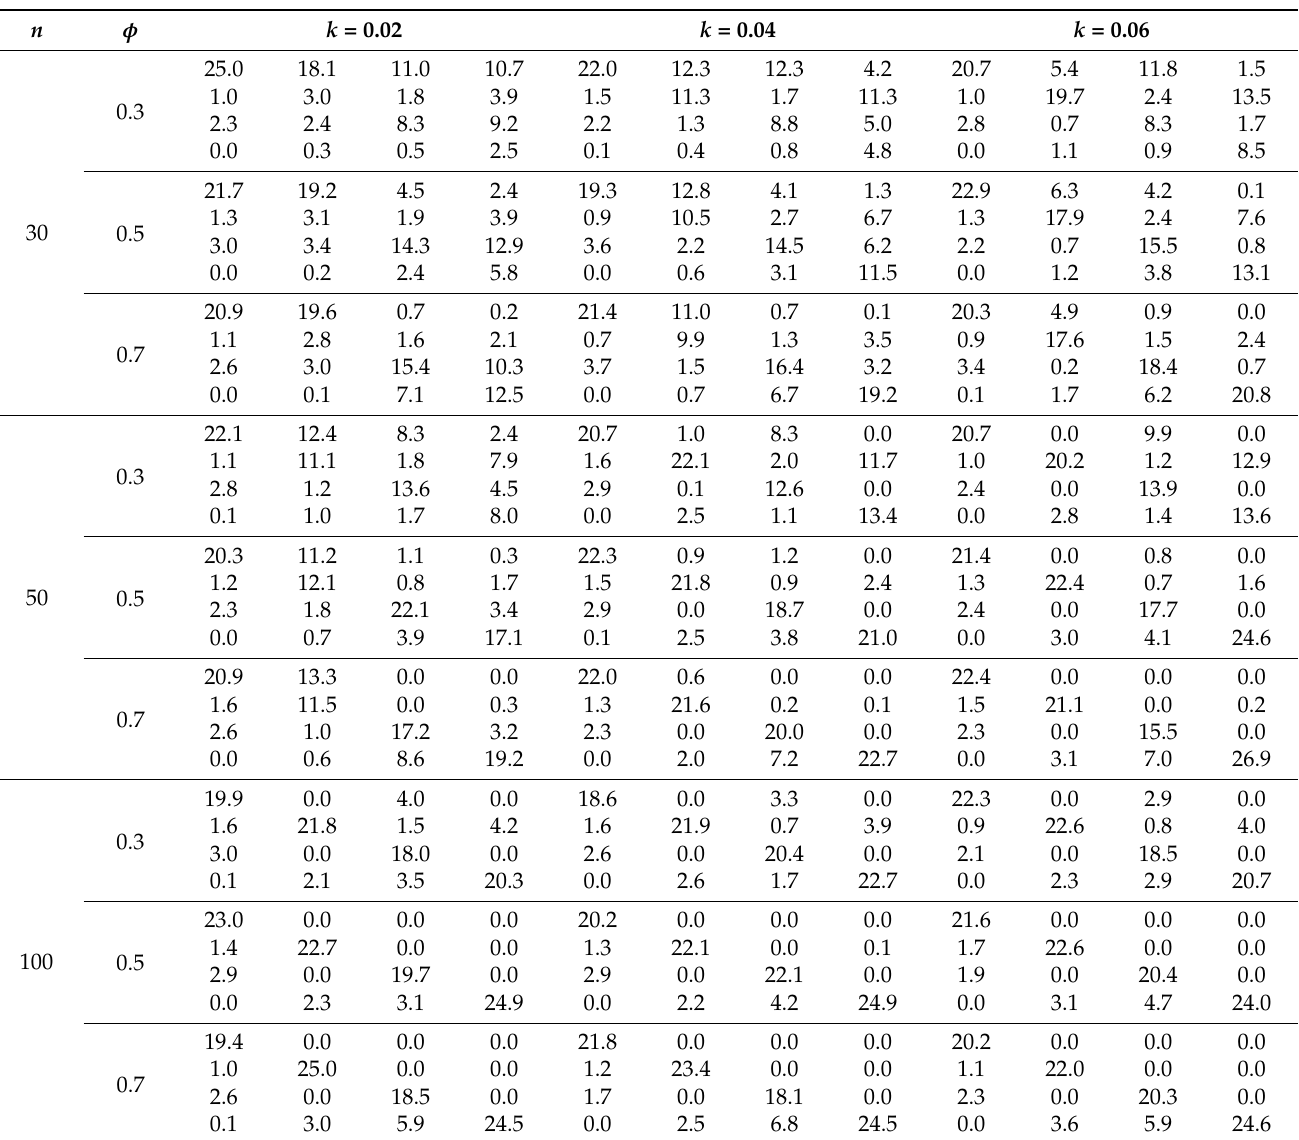
Table A2. SRF matrixes derived by the OW operation in simulation experiment 2 at the 5% signifi- cance level. Unit: